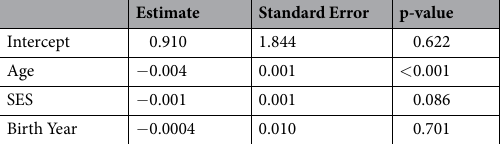
Table 3. Maternal age and socioeconomic status (SES) as well as offspring birth year predicting sex ratio at birth (n births = 106,645) from 1918–1939.